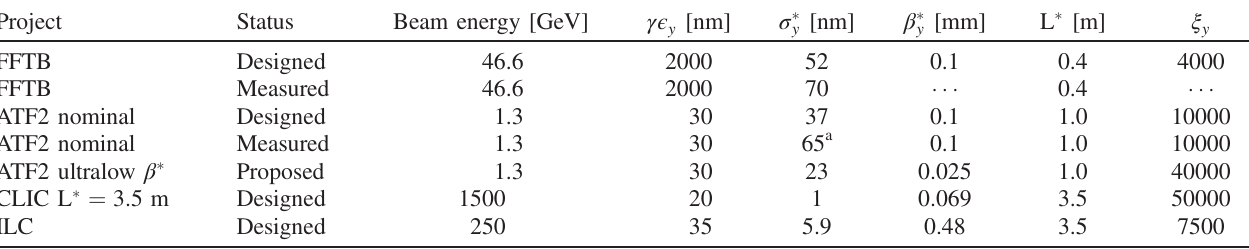
TABLE I. Comparison between relevant parameters of different final focus systems. Project